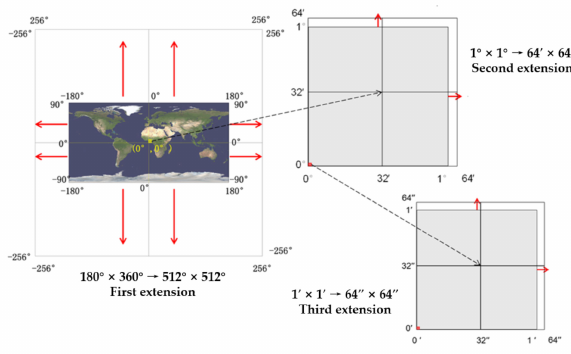
Figure 2. GeoSOT mesh three expansion process